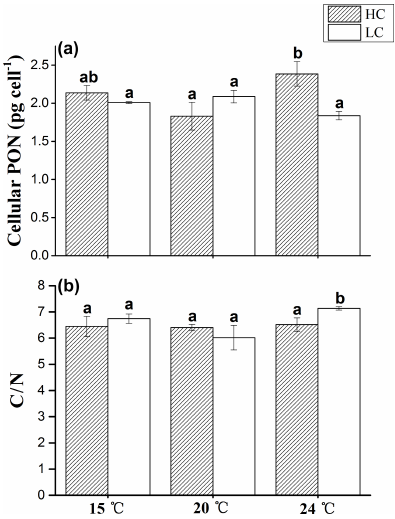
Figure 4. The cellular PON content (a) and C / N ratio (b) of E. huxleyi grown in 400µatm (LC) and 1000µatm (HC) CO 2 con- centrations at 15, 20 and 24 ◦ C, respectively. The different letters above the bars indicate significant differences among the treatments ( p < 0 . 05). The values are the means, and the error bars are stan- dard deviations for triplicate cultures for each